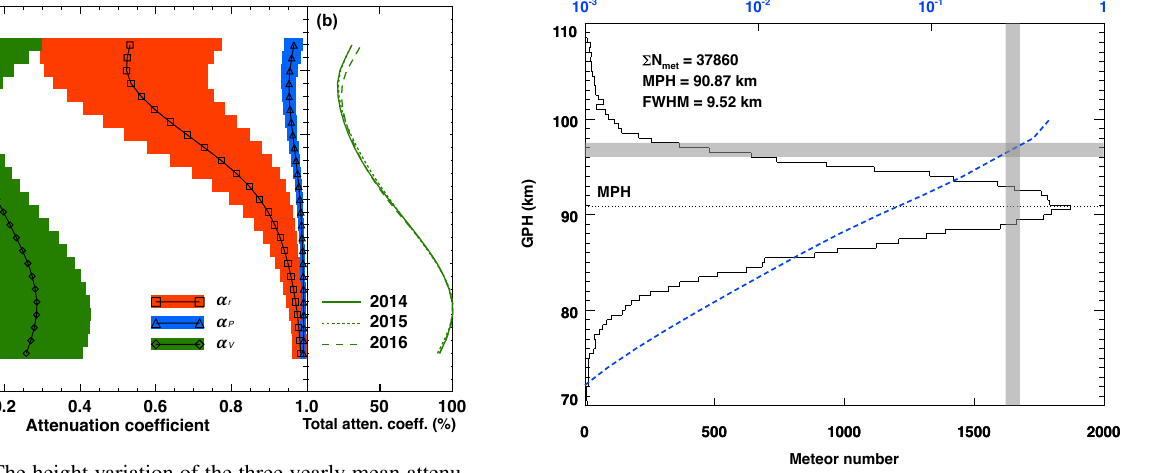
Figure 5. The histogram of a meteor height distribution observed by the KSS meteor radar on a single day in 2016 using a 500m bin. The blue dashed line presents the mean free path of the background at- mosphere calculated from the MLS observations. The gray-colored horizontal bar indicates the height layer where a rapid decrease in meteor detection rate due to the meteor echo height ceiling appears. The typical range of the molecular mean free path that activates the meteor echo height ceiling due to the initial radius and finite veloc- ity factors is depicted by a gray-colored vertical